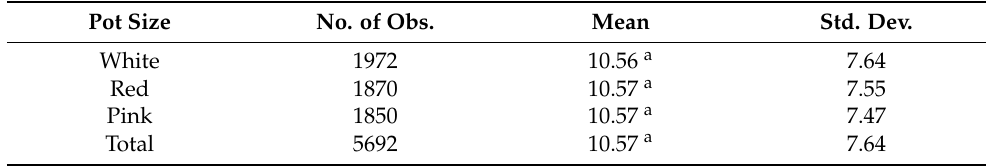
Total Means denoted by the same letter indicate no significant differences between pot sizes ( p ≤ 0.05). Table 4. Willingness to pay for the three poinsettia cultivars by pot sizes. Pot Size No. of Obs. Mean Std. Dev.